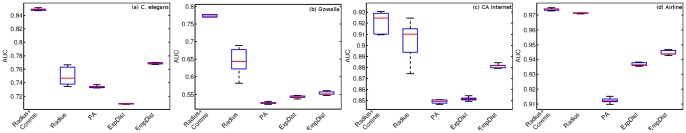
Link prediction AUC over 10-fold cross validation.